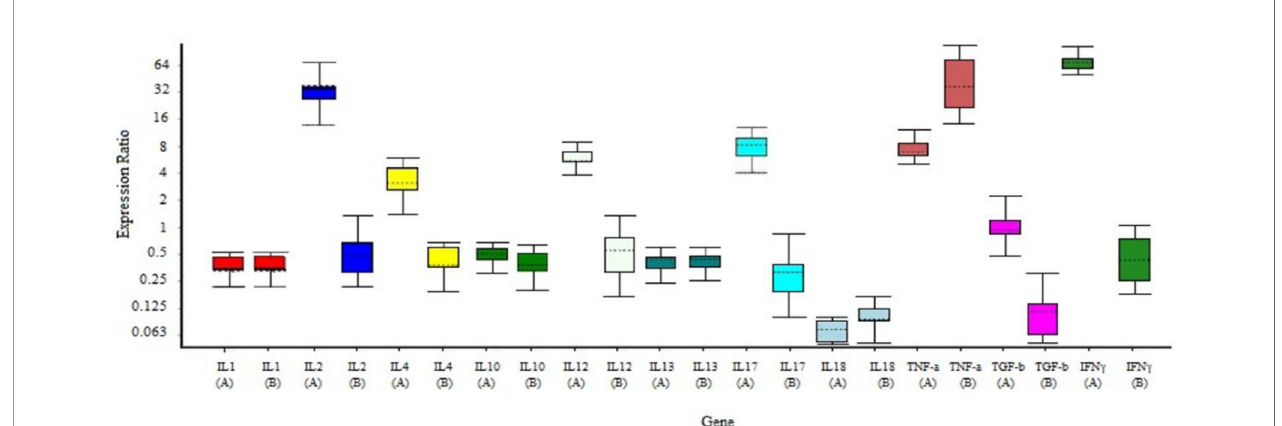
FIGURE 7 | Gene expression pro fi le of the splenocytes from immunized and control mice. Mice were primed-boosted with the middle dose of the RAZI-COV PARS vaccine (A, vaccine) or with the adjuvant RAS-01 only (B, placebo). On 35 days after immunization, mice were euthanized and splenocytes isolated and incubated with S protein for 24 hrs and total RNA was extracted. Gene expression was determined according to the DD Ct using IQ5 software. The results showed that the markers of the in fl ammation such as IL1 and IL18 had no changed in vaccinated group (P>0.05), moreover, the markers of Th1 responses such as IL-2, IL-12, IL- 17, and IFN g are signi fi cantly stimulated following vaccination (P<0.05), while the markers of Th2 responses such as IL-10, IL-4 and IL-13 were induced, but to a limited extent (P>0.05). Mean± SD is depicted in the bar graphs. The statistical signi fi cance was assessed using the Kruskal-Wallis test followed by the two-tailed Mann-Whitney test between the two groups; p values less than 0.05 were considered to be statistically signi fi cant.